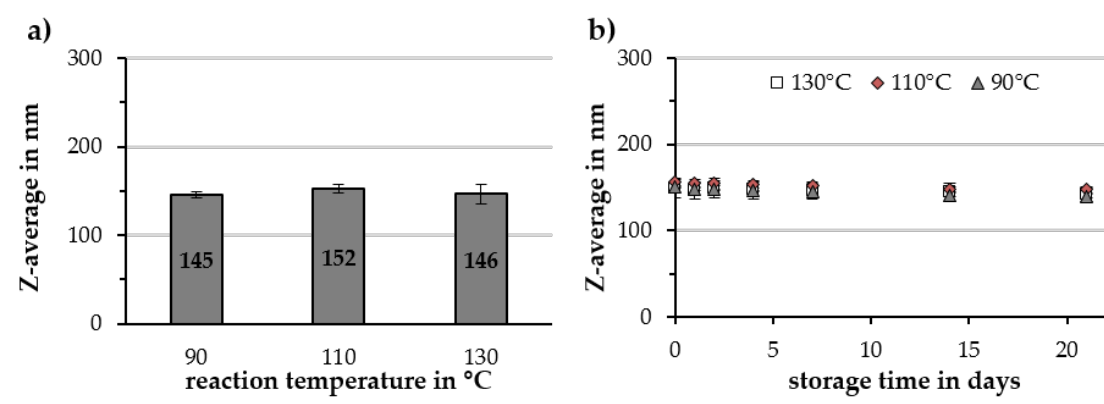
Figure A7. Influence of the reaction temperature measured in an oil bath surrounding the reaction flask on ( a ) the Z-average and ( b ) the particle stability during 21 days of storage in a fridge. Statistically significant changes are marked with * for p < 0.05. Table A1. Comparison of the parameters of Cit-Au-SPIONs with varied reaction temperatures. Reaction Temp.